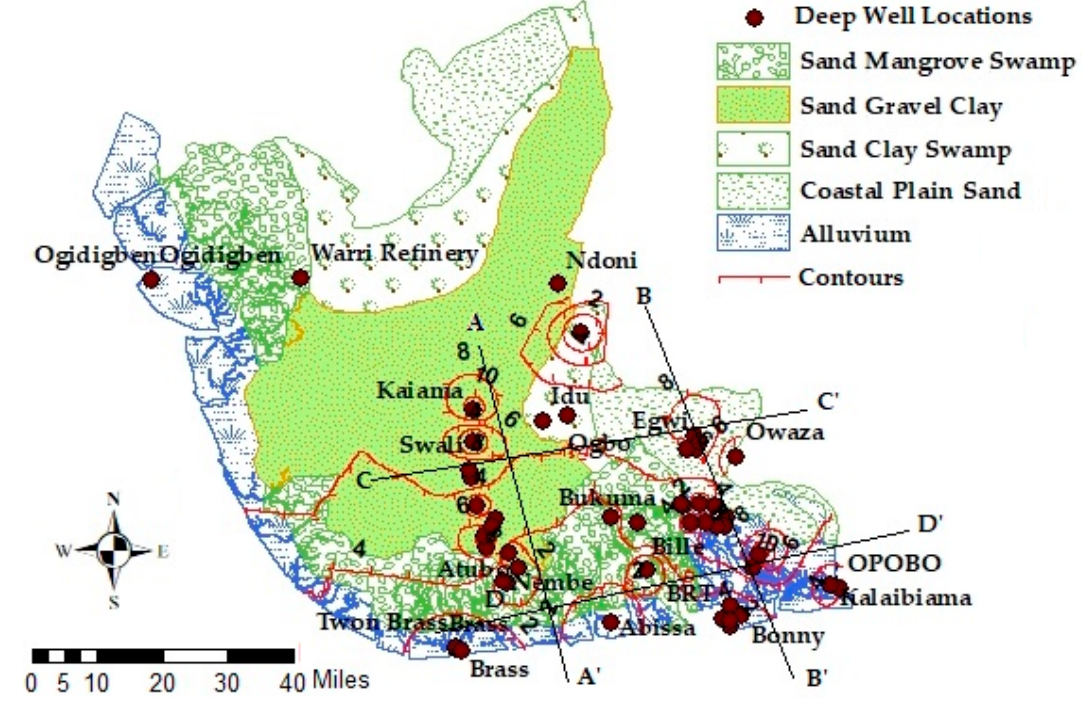
Figure 2. Geology map (Adopted and Modified from [33]) of the study area showing cross-section lines along which lithosections are developed. Table 2. Borehole locations with strata logs, their depths and static water levels.